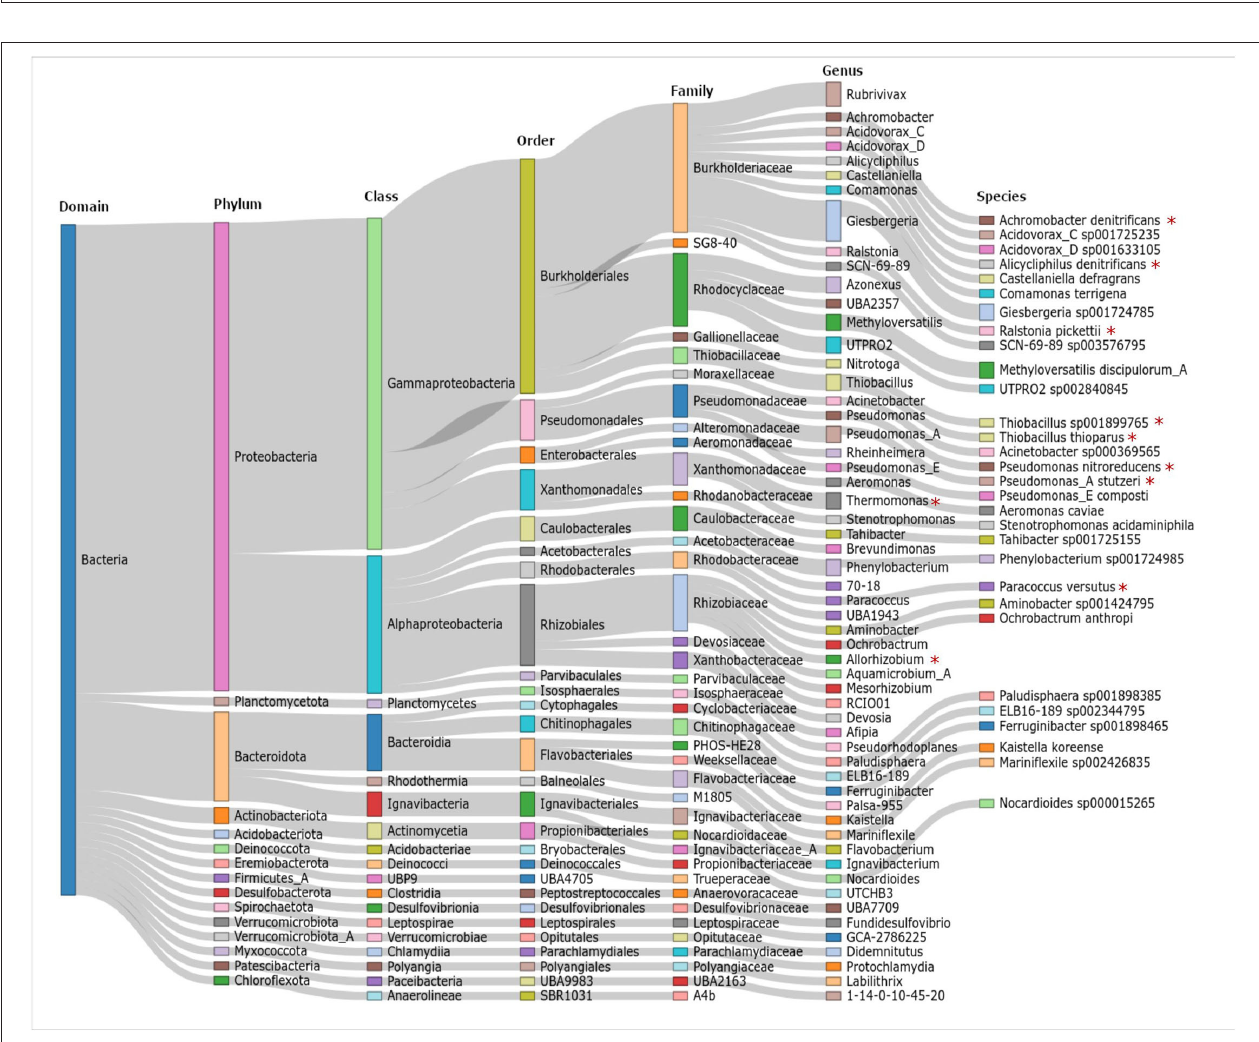
FIGURE 2 | first and second redox sites ( E f2 ) were determined by calculating the arithmetic mean of the anodic and cathodic peak potentials. (C) Reactor 2, 1st sampling unit (close to CC), day 253. (D) Reactor 3, 2nd sampling unit (more distant to CC), day 310. For experiments at different pH values (i), gravimetric current density ( j ) at formal potentials (E) E f1 and (F) E f2 were quantified at every pH ( j pHi ) and normalized with the gravimetric current density at pH 7 ( j pH7 ). Per definition, the normalized gravimetric current density was 1 at pH 7. The scan rate during CV was 1mV s − 1 , only 3rd scans are shown. Errors bars indicate standard deviations. n indicates the number of analyzed granules.